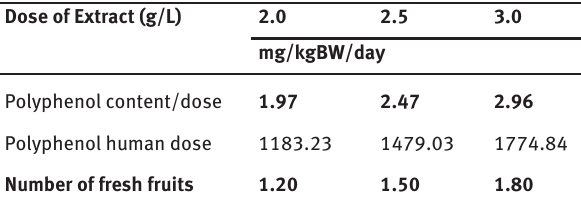
Table 2: Polyphenol-supplementation per kilogram of body weight per day and equivalence to a daily dose for a 60-kg human adult.